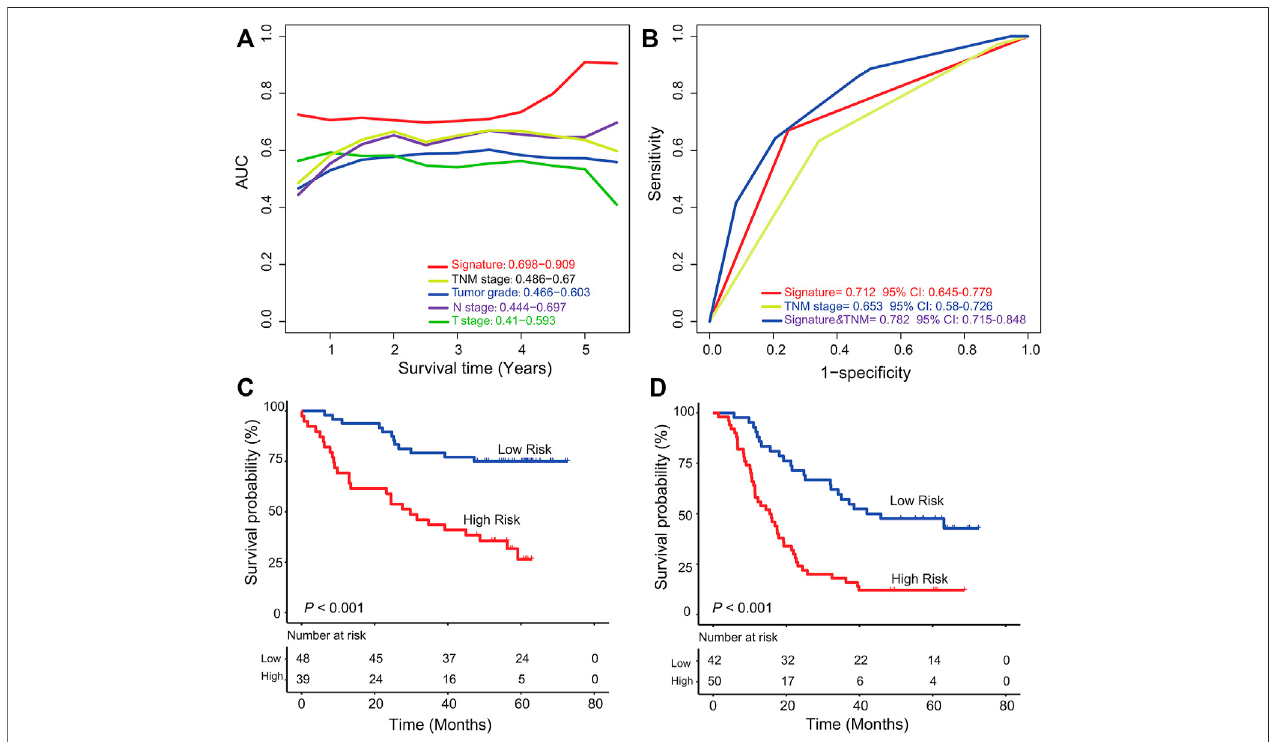
FIGURE 4 | Comparison of TNM stage and the six-lncRNA signature and strati fi cation analysis. (A) Time-dependent ROC curve analysis of the six-lncRNA signature and other clinical characters in the GSE53625 group. (B) Comparison of survival prediction performance of TNM stage and the six-lncRNA signature. The signature could further classify ESCC patients from TNM high (C) /low (D) stage into two groups according to markedly different